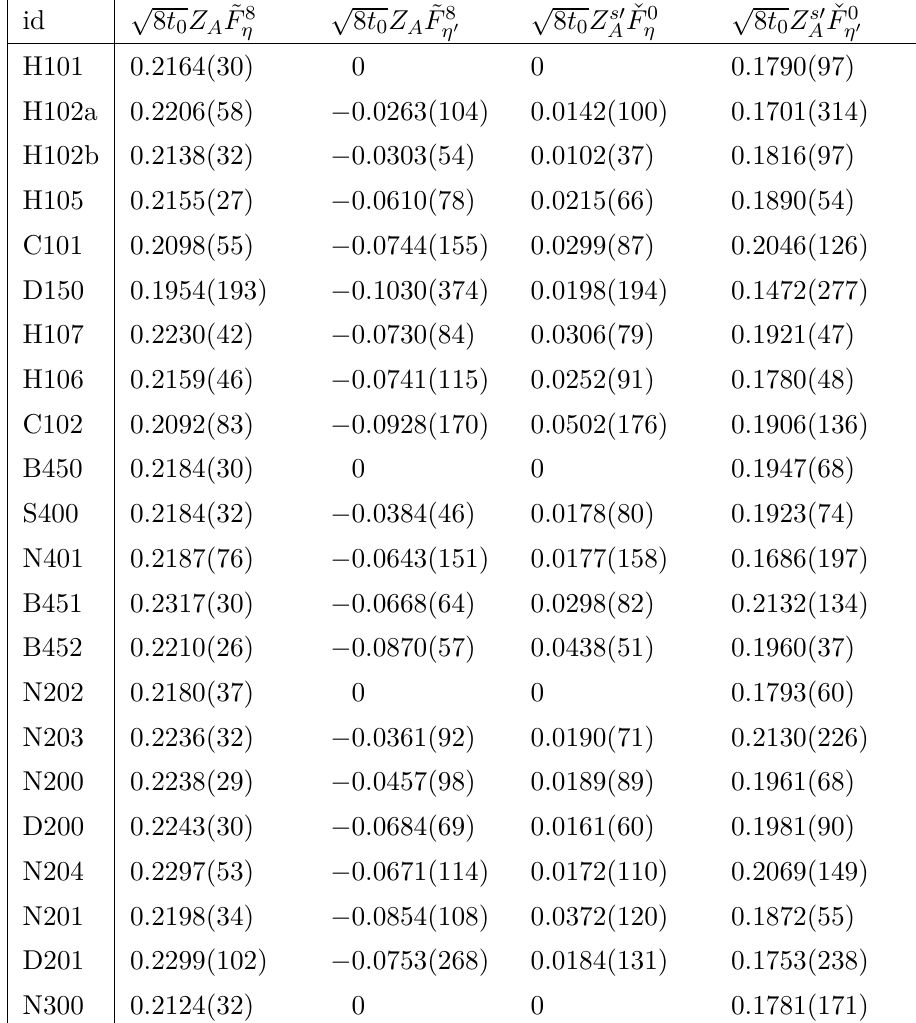
√ 8 t 0 (determined on